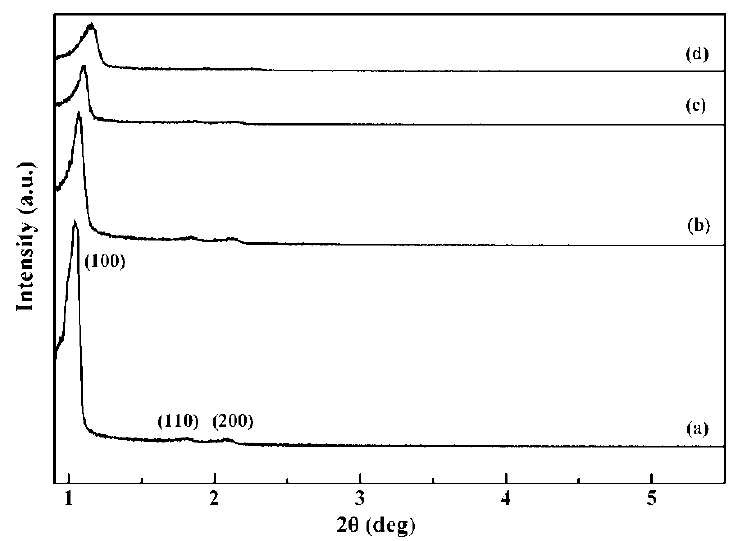
Figure 3. Small-angle XRD patterns of the catalysts. ( a ) SBA-15; ( b ) Ni/SBA-15;